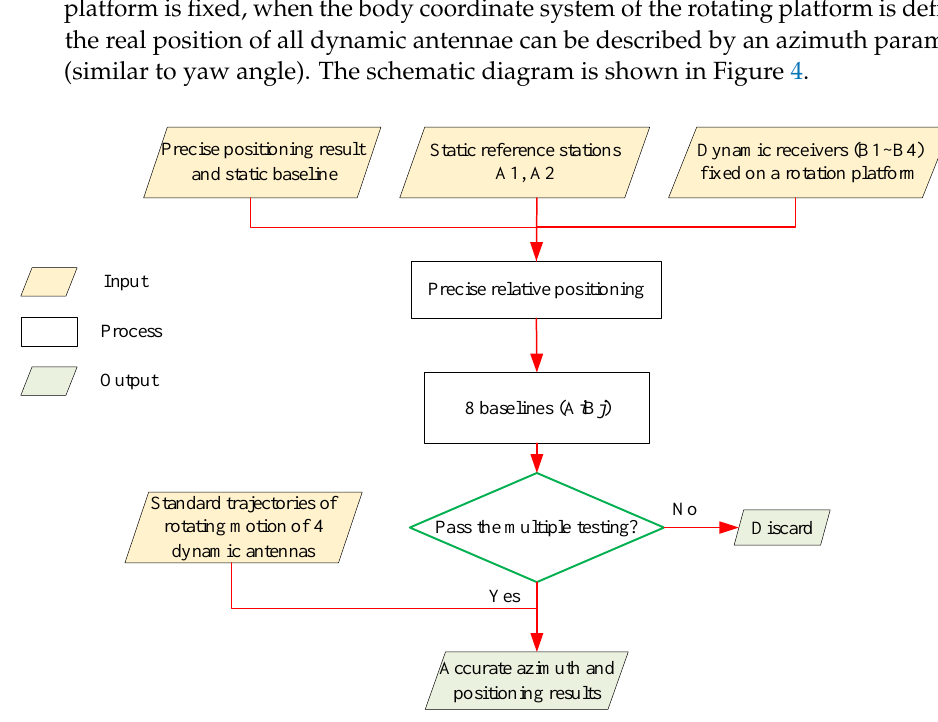
Figure 4. Calculate the valid precise relative positioning results. (d) Multiply test to ensure the accuracy of the positioning results. Error analysis requires sufficiently accurate positioning data as reference. Even for ultra-short baselines,